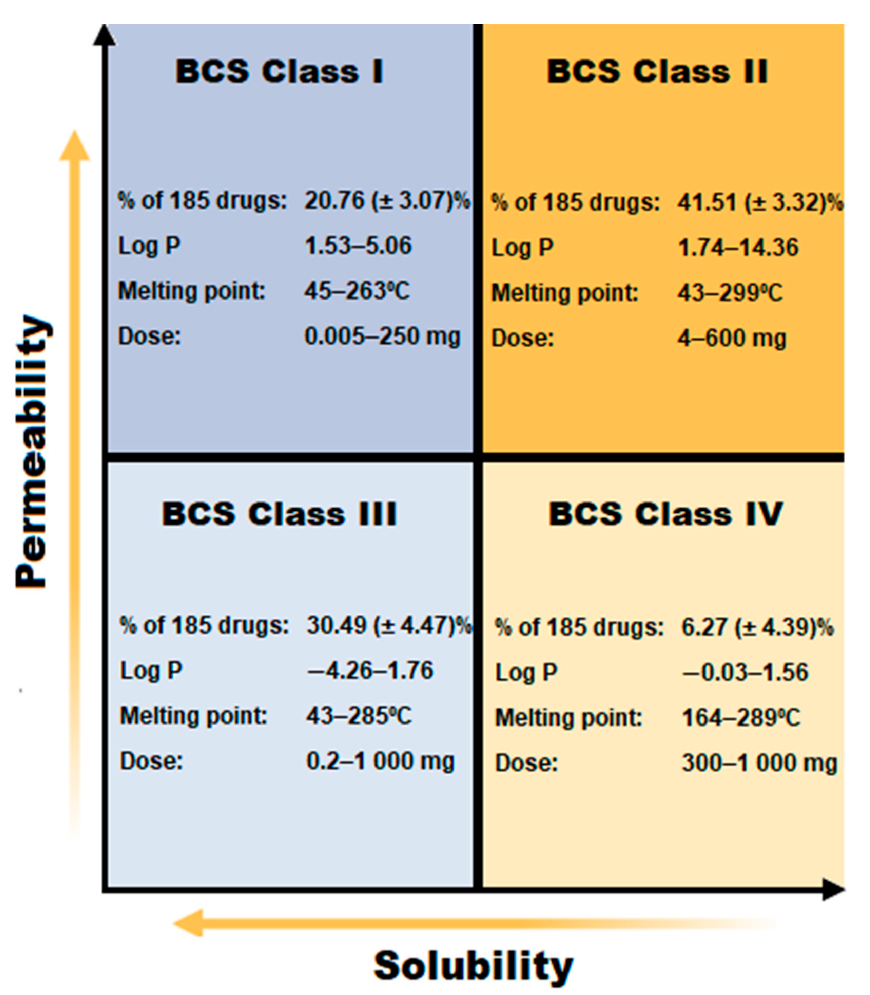
Figure 1. Biopharmaceutical Classi fi cation System (BCS) [23].